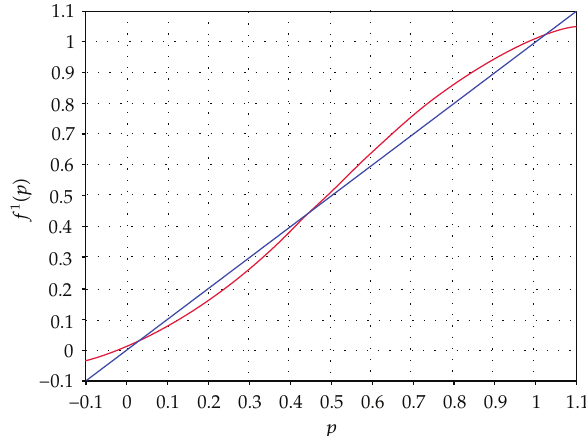
Figure 4: Phase diagram. Replicator dynamics—Example 4.3.